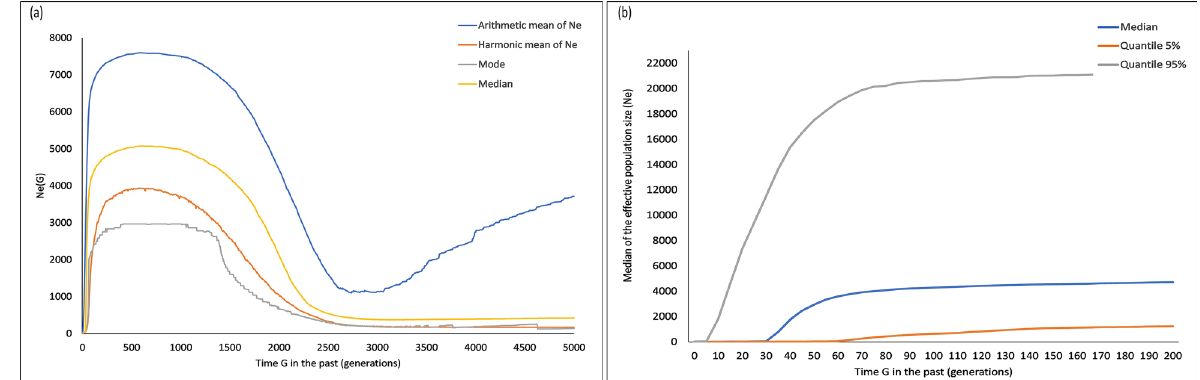
Figure 5. Estimates of effective population size ( Ne ) of R. e. eldii in KLNP based on 19 microsatellite loci using approximate likelihood MCMC approach in VarEff v.1.2 package in R ( a ) Ne estimates from present to 5000 generations in the past and ( b ) present to 200 generations in the